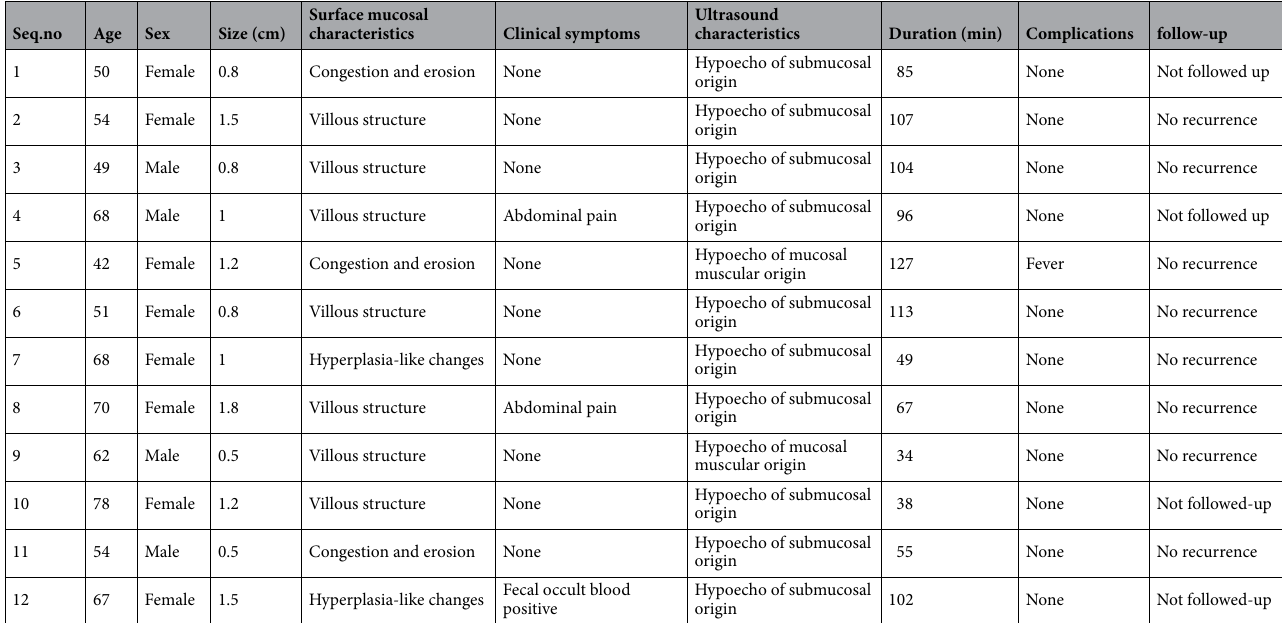
Table 1. Clinical characteristics of cases.